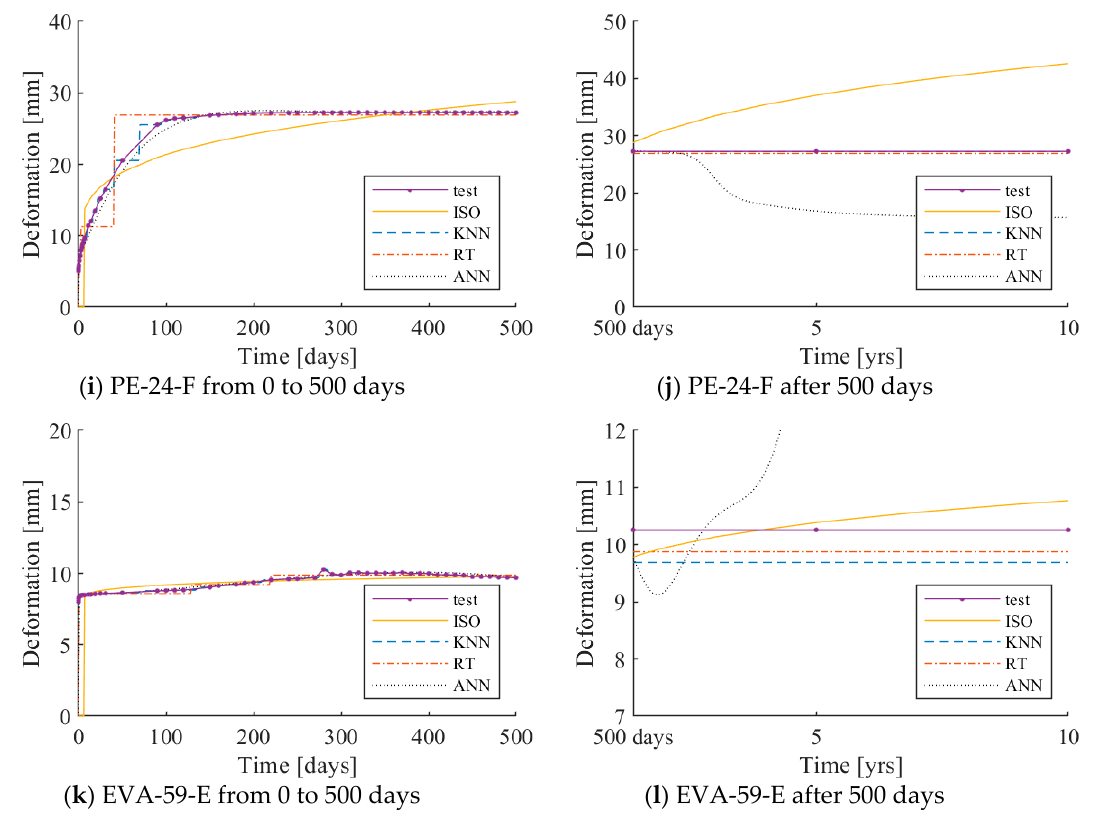
Figure 7. Long-term deformations as predicted by ISO 20392 (solid), KNN (dashed), RT (dash-dot), and ANN (dotted) compared to the experimental data under 500 N loading.